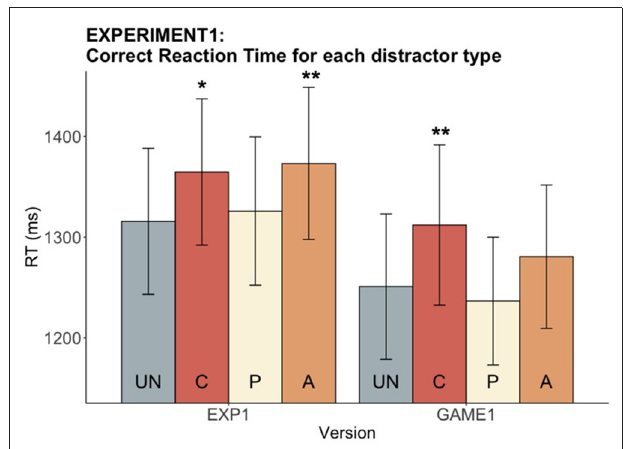
FIGURE 3 | Experiment 1: Reaction time for each distractor type in both versions. The bar chart indicates the mean correct RTs while the error bars shows the 95% confidence intervals. Distractor conditions are color-coded. UN (gray; first bar) is the baseline condition that the other three conditions were compared to. Significance levels show significant difference from UN (* p < 0.05, ** p <